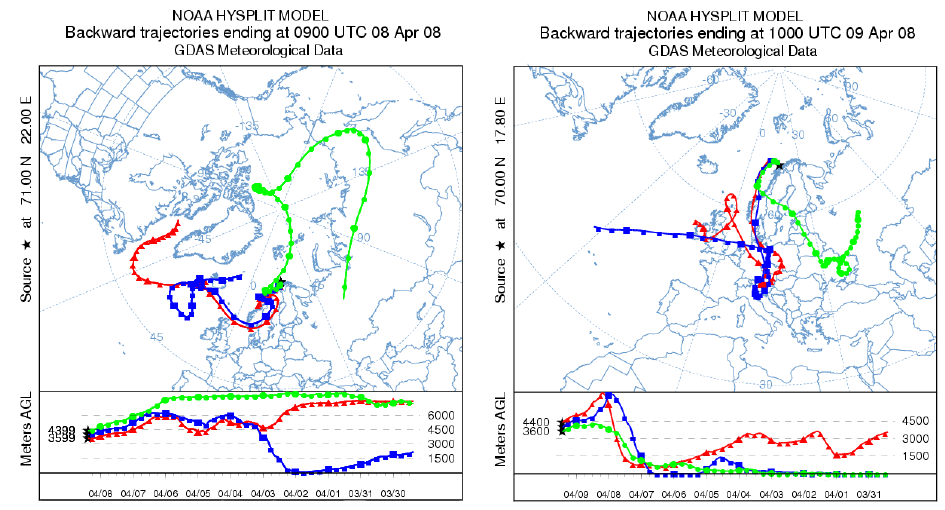
Fig. 14. Back-trajectories for the two soundings’ positions calculated for altitudes of 3.6, 4 and 4.4 km. During flight as0833 (9 April 2008), the air masses are clearly influenced by polluted zones, i.e. the boundary layer in central Europe.